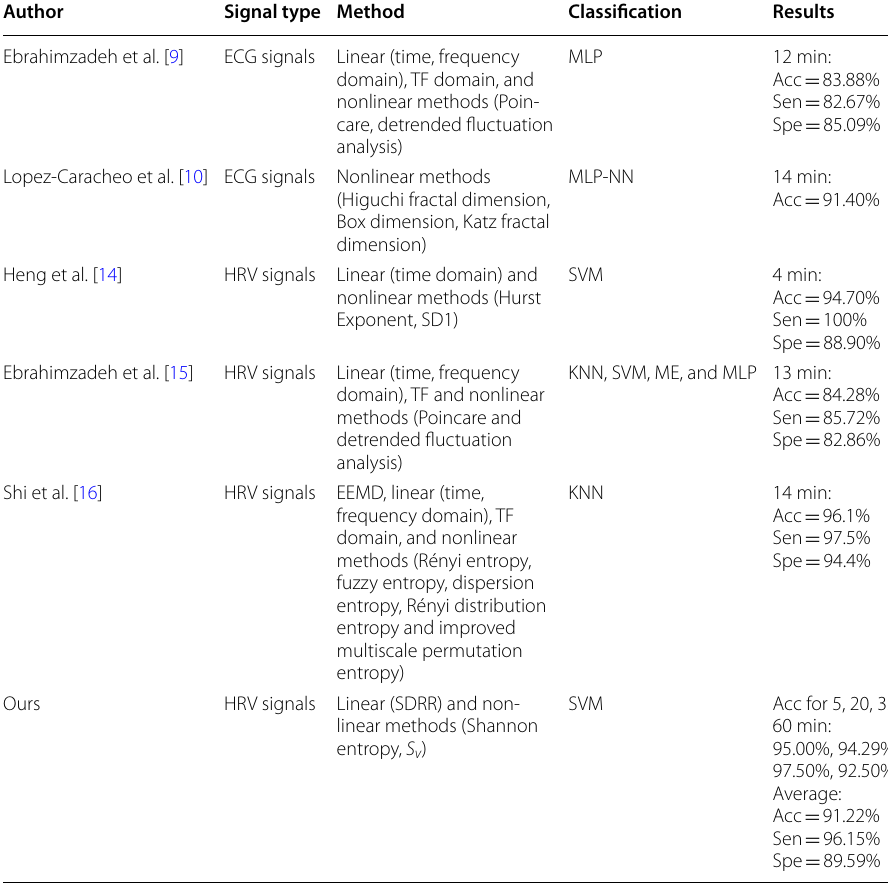
Table 6 Comparison with other methods Author Signal type